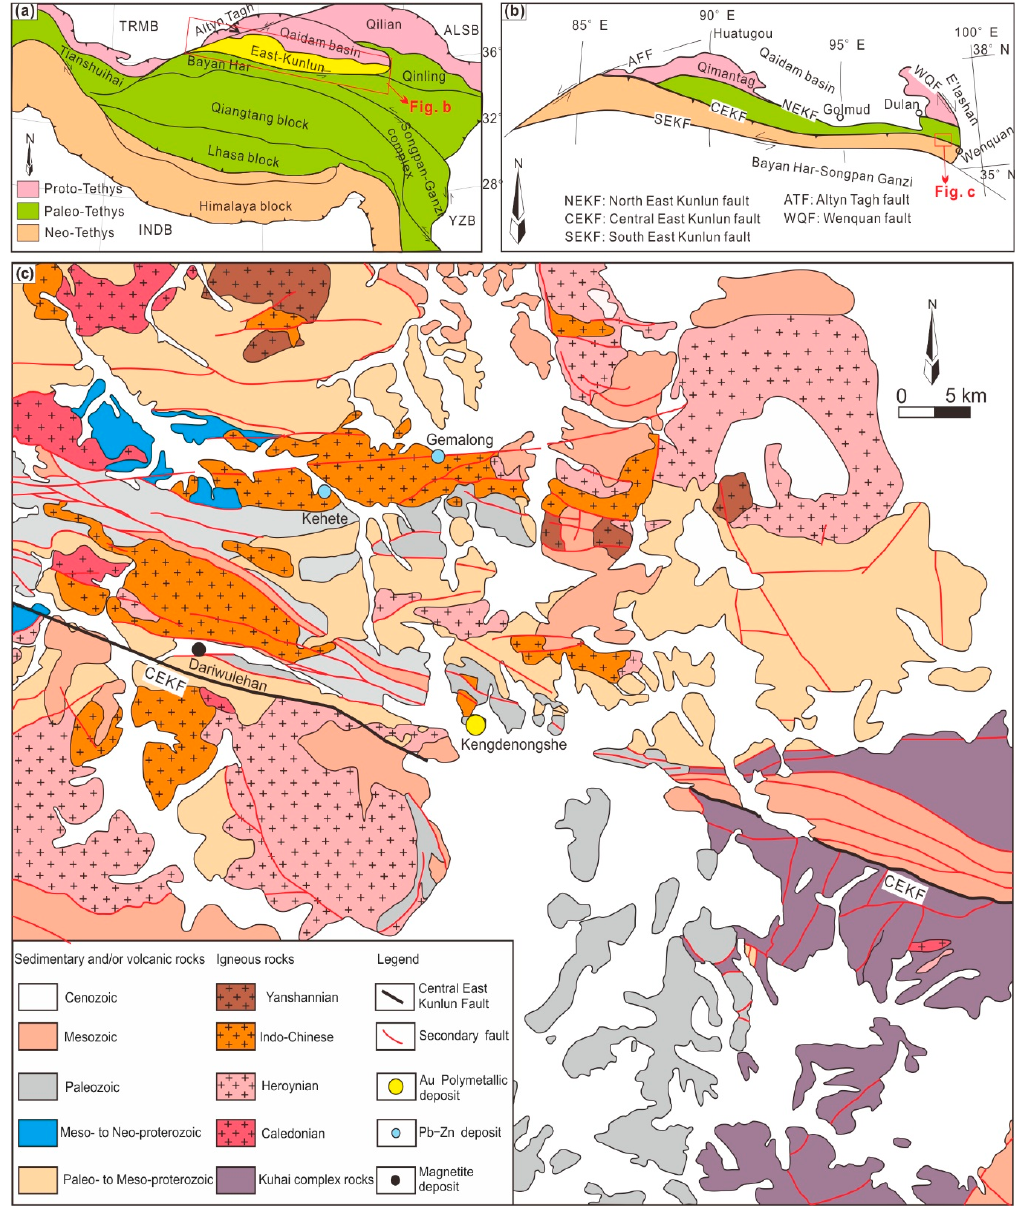
Figure 1. Tectonic outline of the ( a ) Qinghai–Tibetan Plateau, ( b ) East Kunlun Orogen (modified after Reference [19]) and ( c ) simplified geological map of the Kengdenongshe area, the eastern segment of the East Kunlun Orogen (modified after Reference [20]).